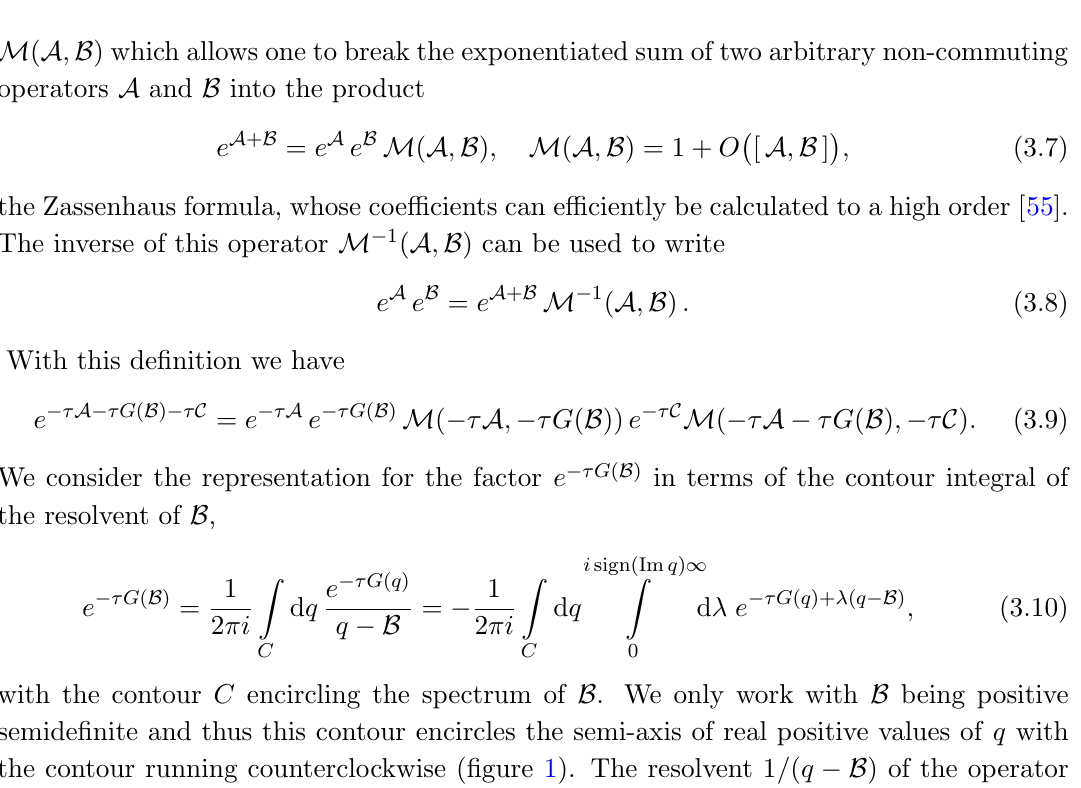
Figure 1 . Contour C in q